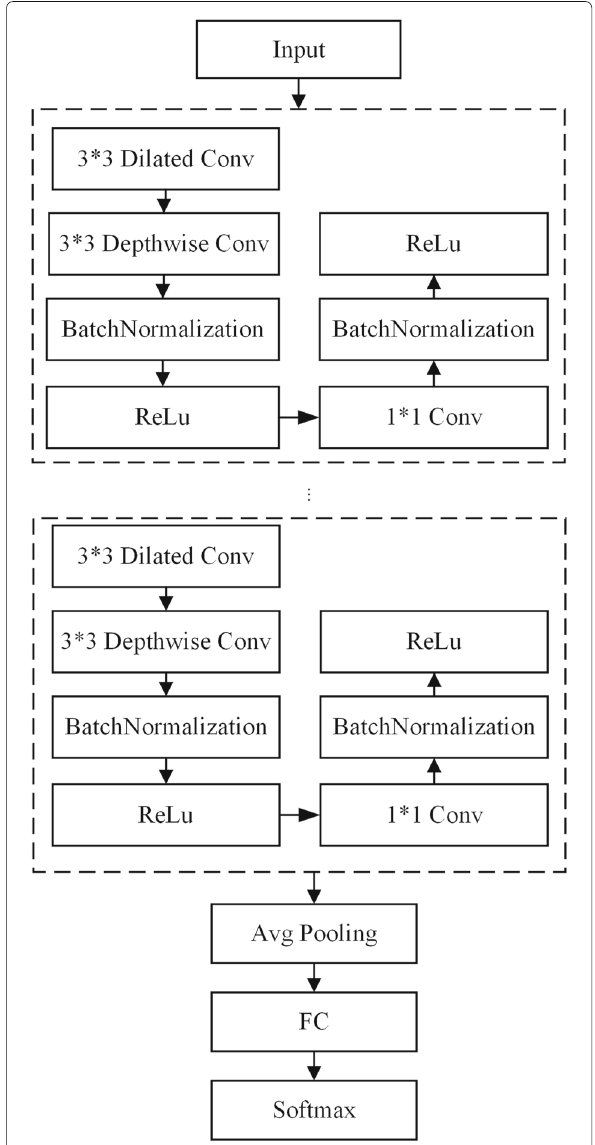
require smaller and faster models. Therefore, this paper refers to two hyperparameters, the width multiplier α and resolution multiplier ρ , to obtain a smaller model. The two hyperparameters reduce the computational complex- ity of the entire network by reducing the computational complexity of the depthwise separable convolution pro- cess. The role of the width multiplier is to thin a network uniformly at each layer. The number of input channels changes from H to α H , and the number of output chan- nels becomes α N from N . As a result, the complexity of the depthwise separable convolution